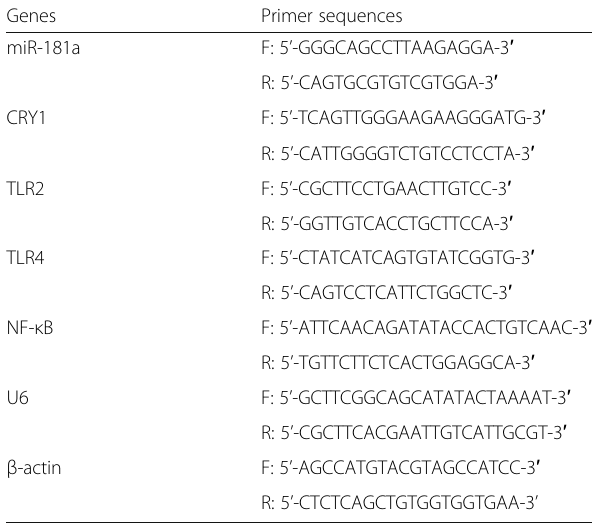
Table 1 Primer sequences for RT-qPCR Genes Primer